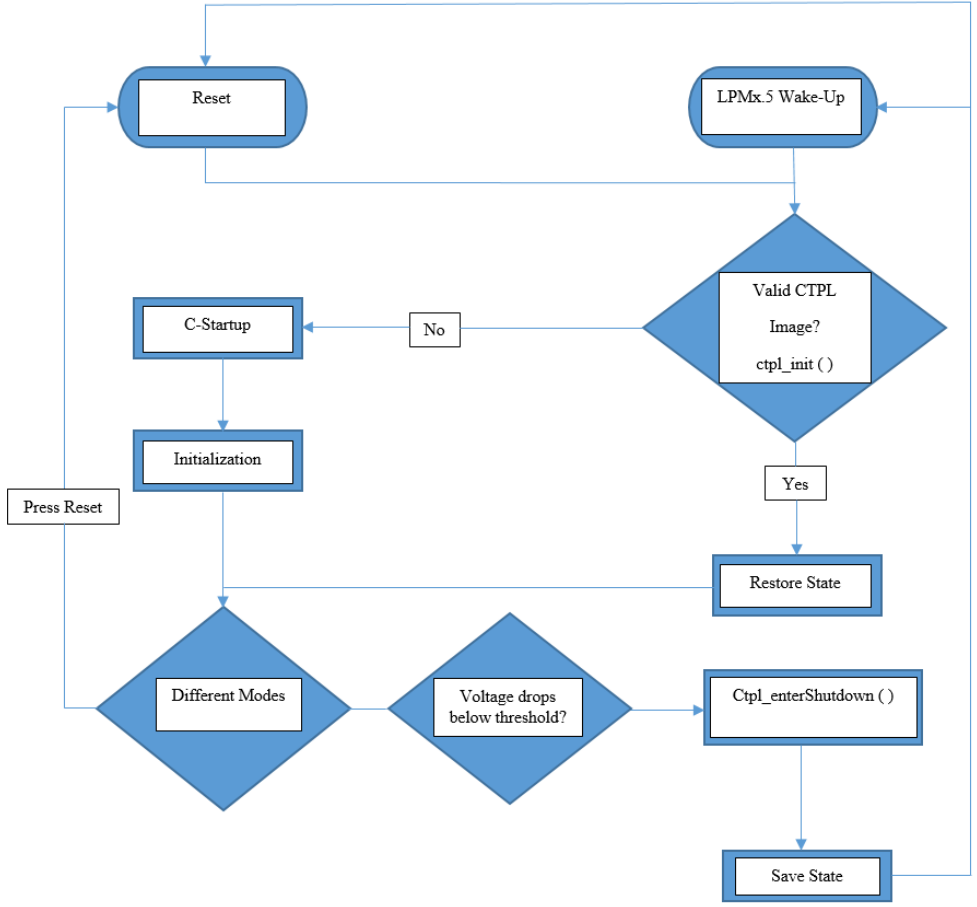
Figure 3 . Selected parts of Texas Instrument’s Compute through Power Loss Utility strategy used for implementing TC. The Ctpl_enterShutdown () function is triggered when the power supply voltage drops below the threshold. Adapted from [28].